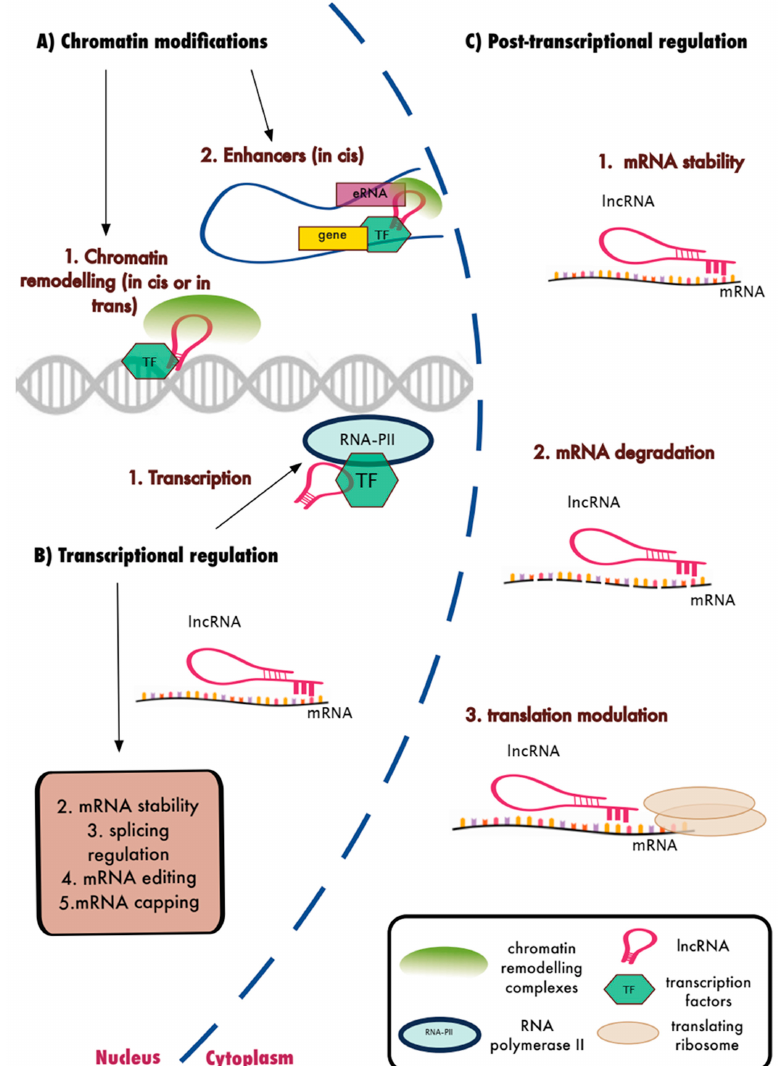
Figure 2. Biological functions of lncRNAs. LncRNAs were shown to interact with protein coding genes and their transcripts to regulate gene expression. ( A ) Nuclear lncRNAs interact with chromatin remodelling factors and TFs to regulate the expression of neighbouring or distal genes. ( B ) Nuclear lncRNAs also regulate transcription and several other transcriptional events of RNA processing. ( C ) Cytoplasmic lncRNAs were shown to interfere with post-transcriptional regulation such as mRNA stability and degradation as well as translational regulation of mRNAs.